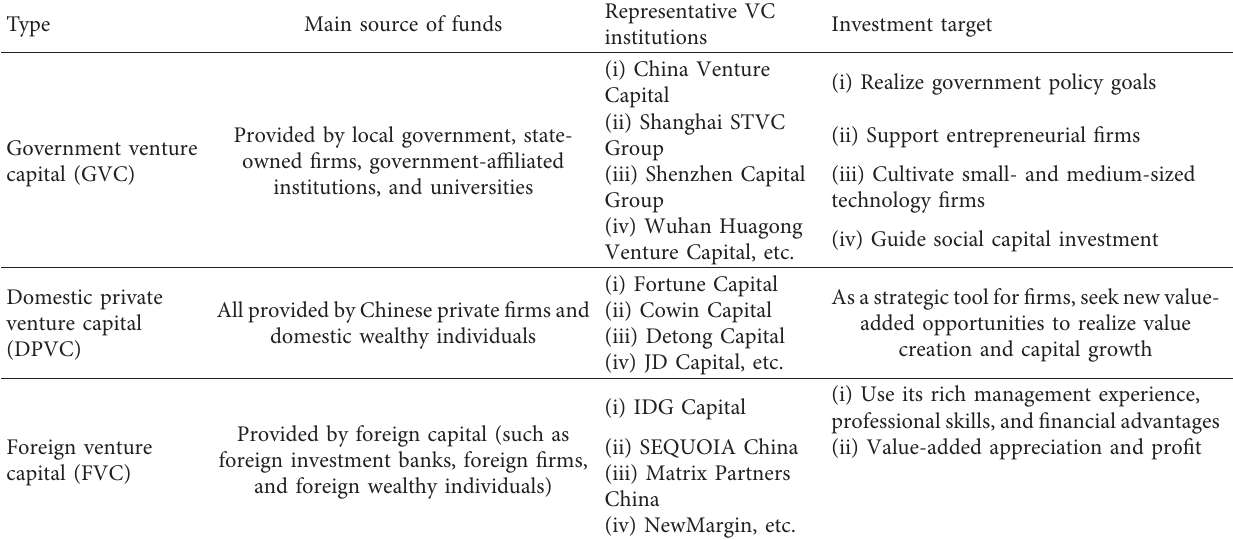
Table 1: Classification of Chinese venture capital